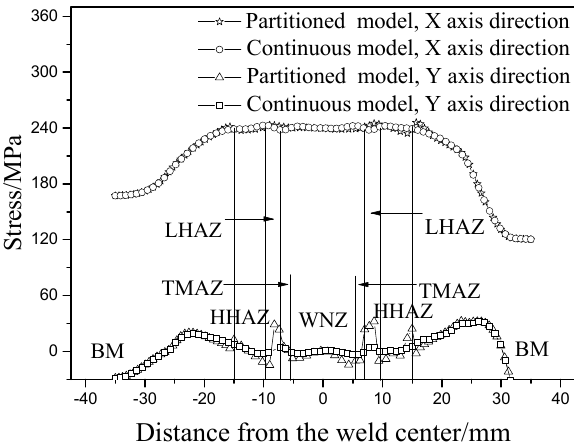
Figure 13. Stress distributions in the X and Y directions in upper surface of the joint model.